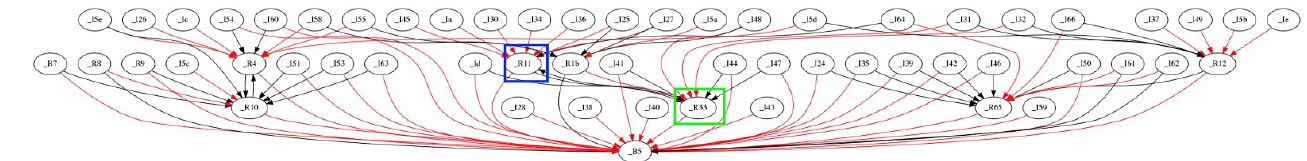
Figure 5. The PEAR impact on network topology evolution: phase 2. The device highlighted with the green square belongs to a low energy profile whereas the device belonging to a high energy profile is highlighted with a blue square.